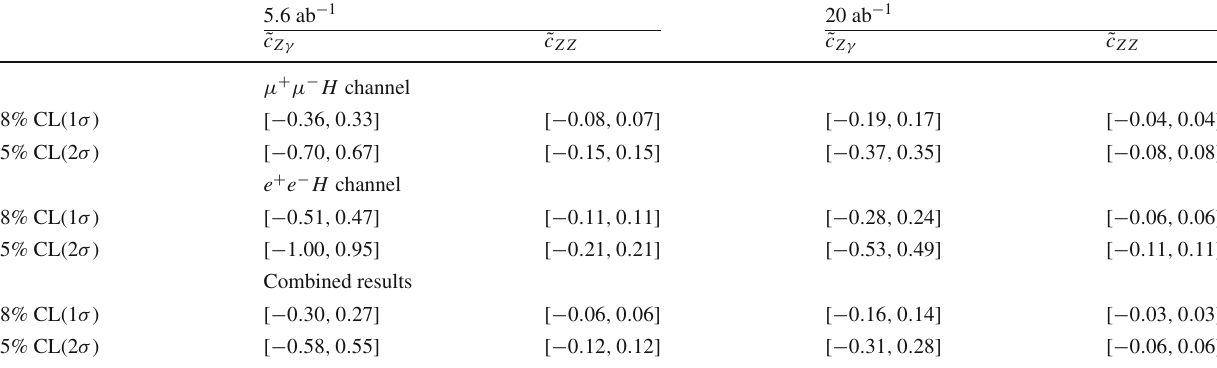
Table 4 Summary of 1 σ and 2 σ bounds on CP -violating parameters ˜ c Z γ , ˜ c ZZ from various analyses considered in our study with different channels by fitting to ω with 5 . 6 ab − 1 and 20 ab −